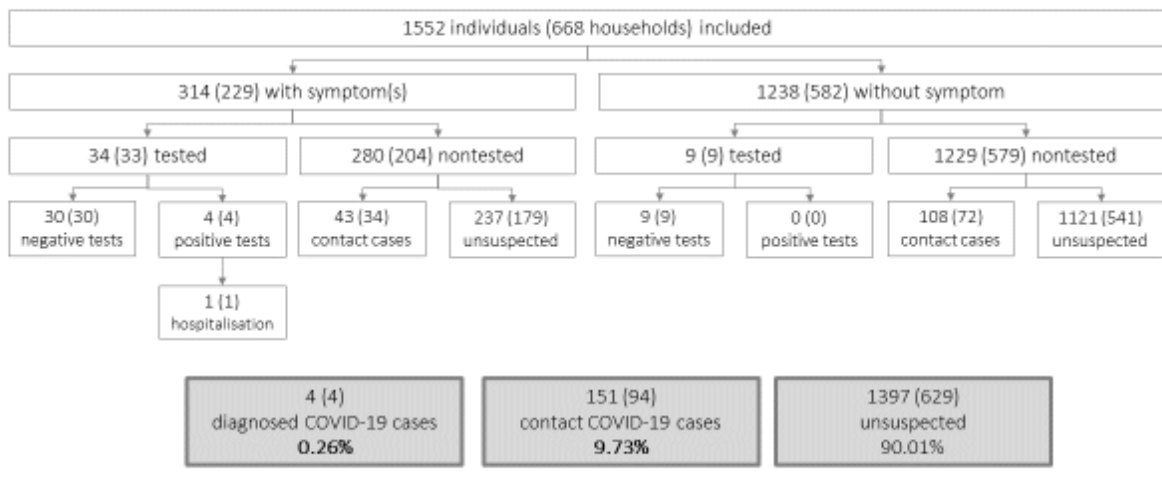
Figure 4. Final reporting of the testing process among individuals and households